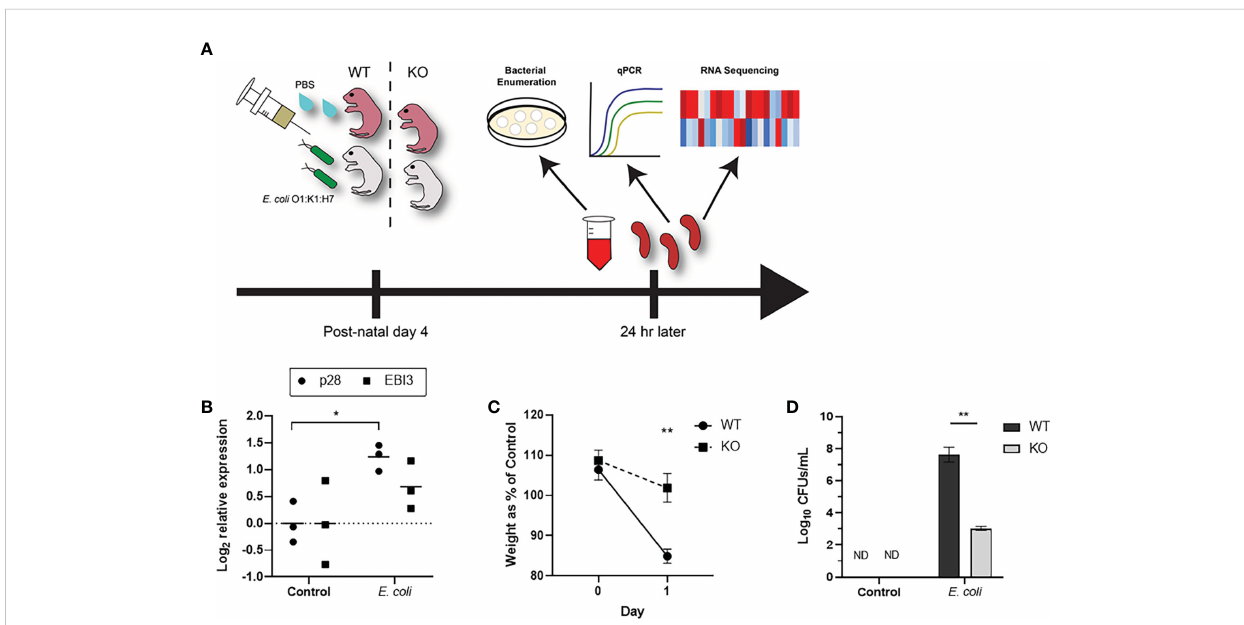
FIGURE 1 IL-27 signaling compromises control of bacteria during neonatal sepsis. (A) A schematic to illustrate the study design to pair transcriptional analysis with infection related outcomes. Neonatal mice were subcutaneously inoculated with E. coli O1:K1:H7 (n=3) or PBS (n=3) as a control on day 4 of life. (B) The expression of IL-27p28 or EBI3 in the infected spleen at 1-day post-infection was determined relative to tissues from uninfected controls by real-time PCR using the formula 2 − DD Ct . Each symbol represents an individual animal analyzed further in this study with the mean for each